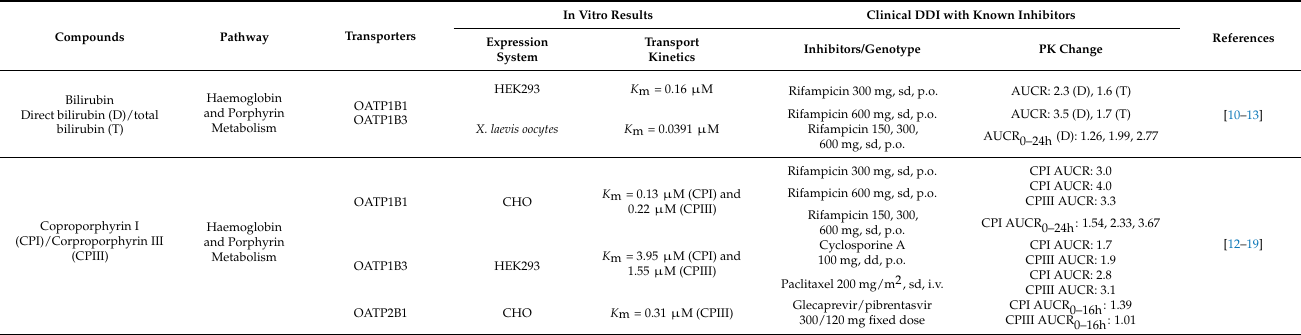
Table 1. List of endogenous biomarkers (candidates) of drug transporters for DDI evaluation. Compounds Pathway Transporters